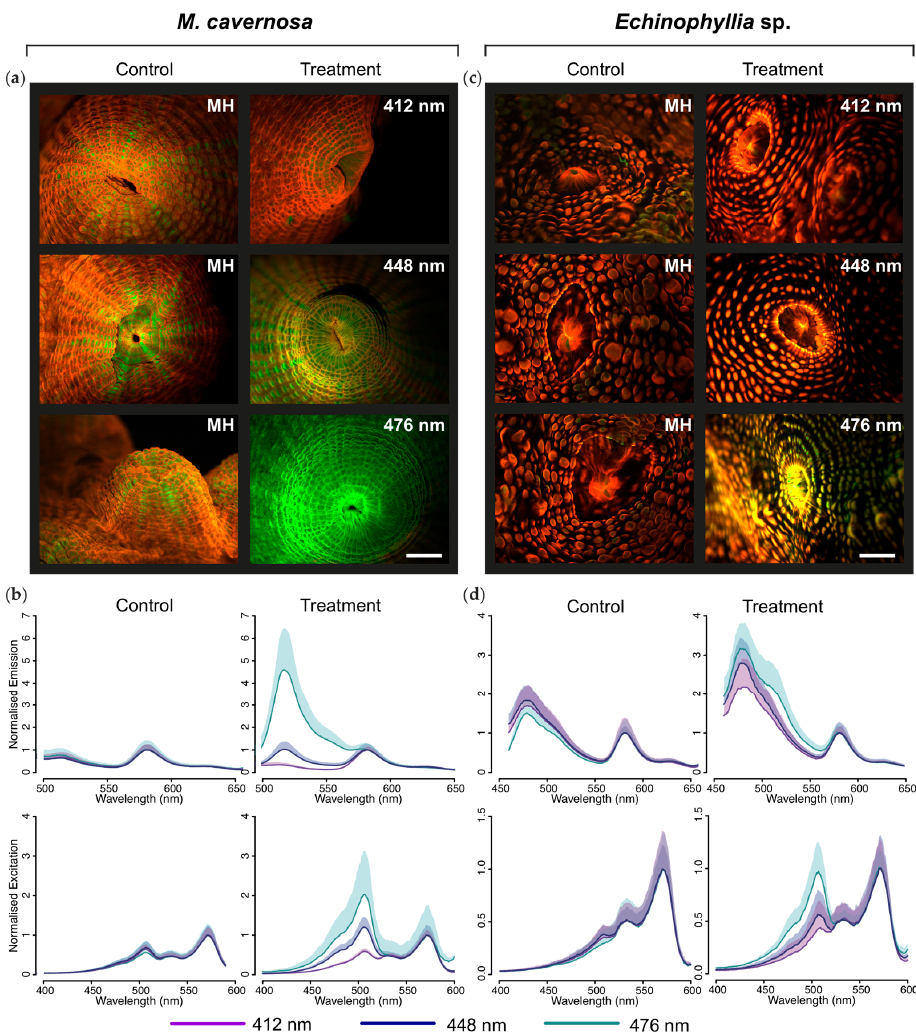
Figure 2. Fluorescence of M. cavernosa and Echinophyllia under metal halide or narrow-waveband light-emitting diode (LED): ( a , c ) Fluorescent micrographs of M. cavernosa ( a ), and Echinophyllia sp. ( c ) under metal halide (MH; control) or narrow-waveband LED (412 nm, 448 nm, 476 nm; treatment); scale bar = 2 mm; ( b , d ) Emission spectra obtained with: 450 nm excitation for M. cavernosa ( b ), and 435 nm for Echinophyllia sp. ( d ) Excitation spectra obtained for 620 nm emission. Mean + S.D., n = 6. Spectra are normalised to intensity of the 582 nm peak.